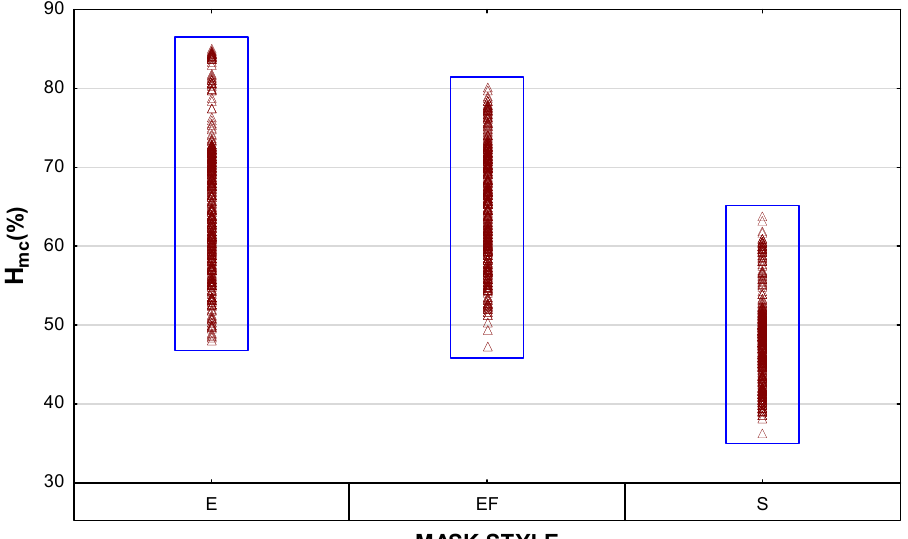
Figure 9. Variability plot of H mc (raw data) per mask style.